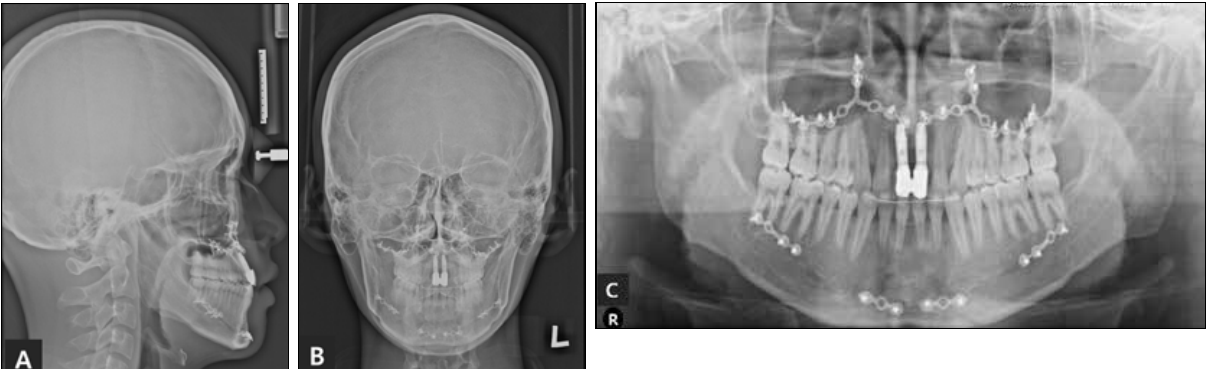
Figure 4. Post-treatment facial and intraoral photographs.